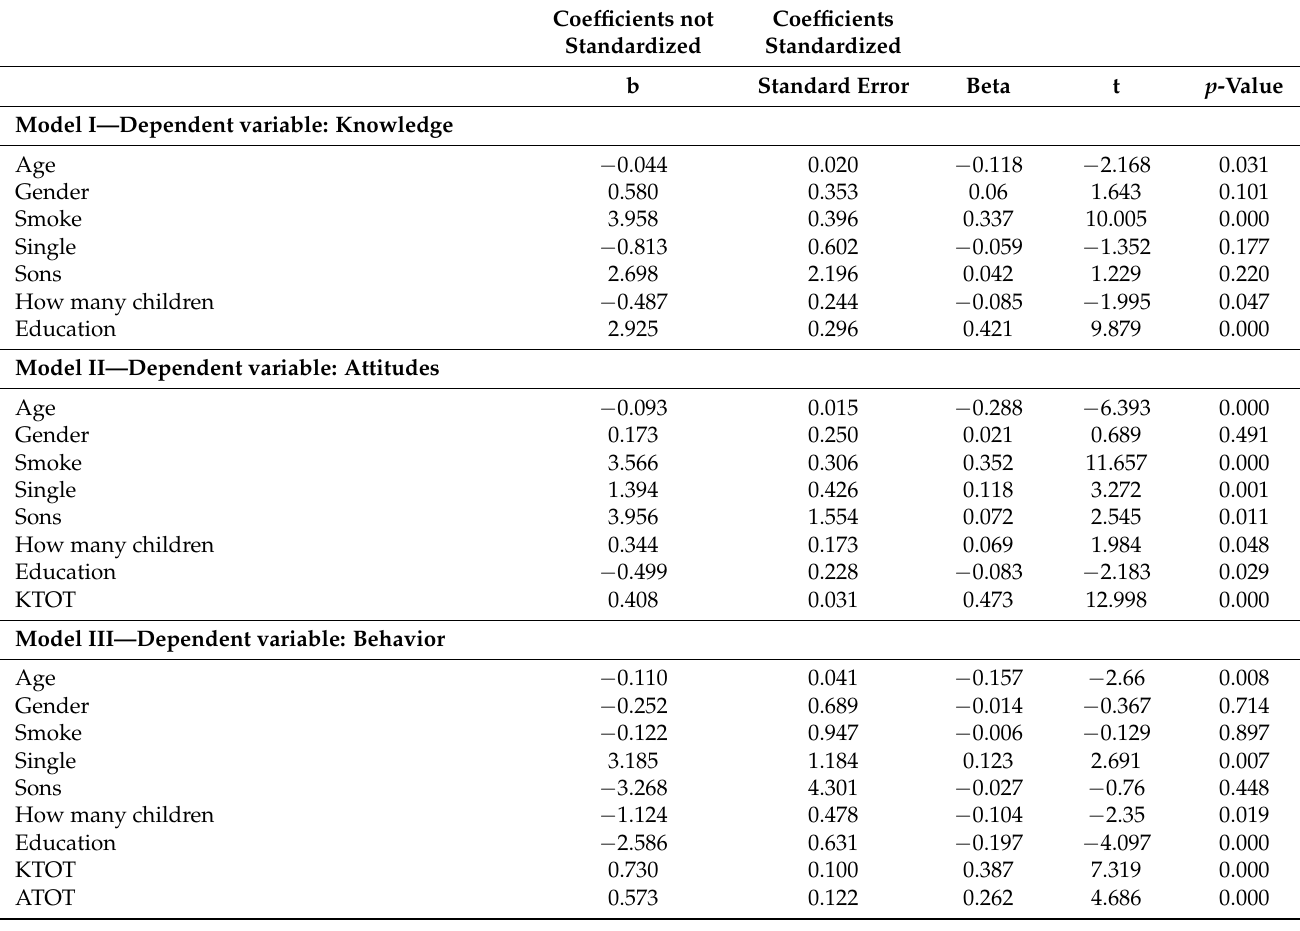
Table 5. Results of the linear multiple